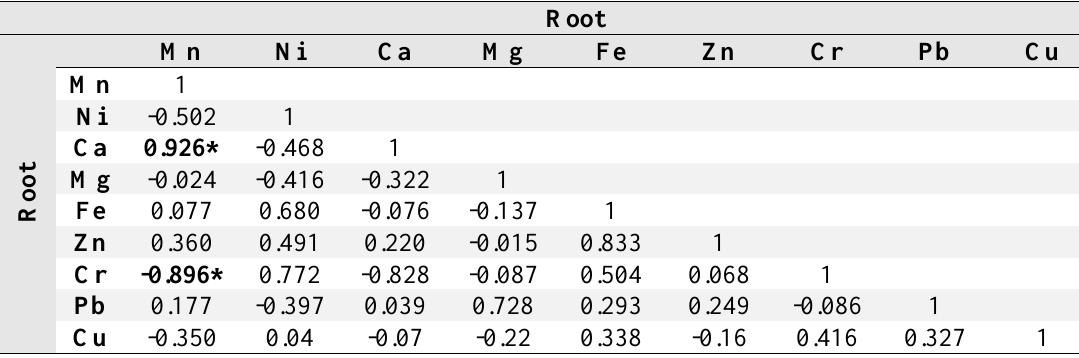
Table 3. Pearson's correlation between heavy metals at the root of Rumex acetosella. Root